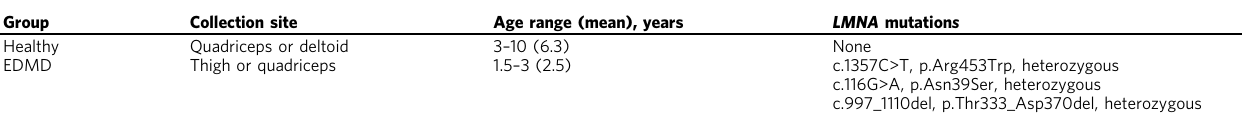
Table 1 Human sample